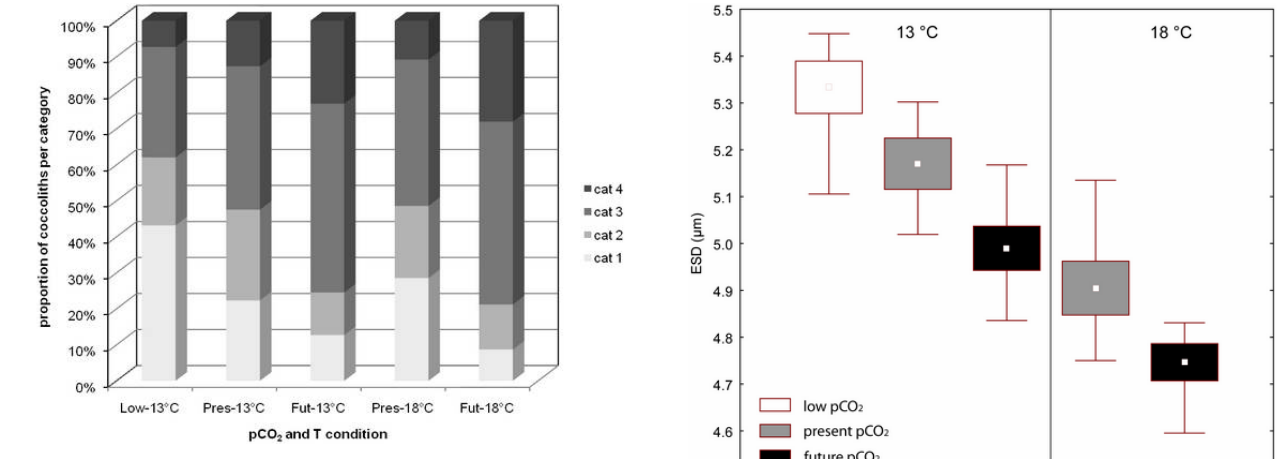
Fig. 4. Percentage of coccoliths per category, from normal coccol- iths (cat. 1) to fragmented coccoliths (cat. 4), for each treatment of p CO 2 and temperature.